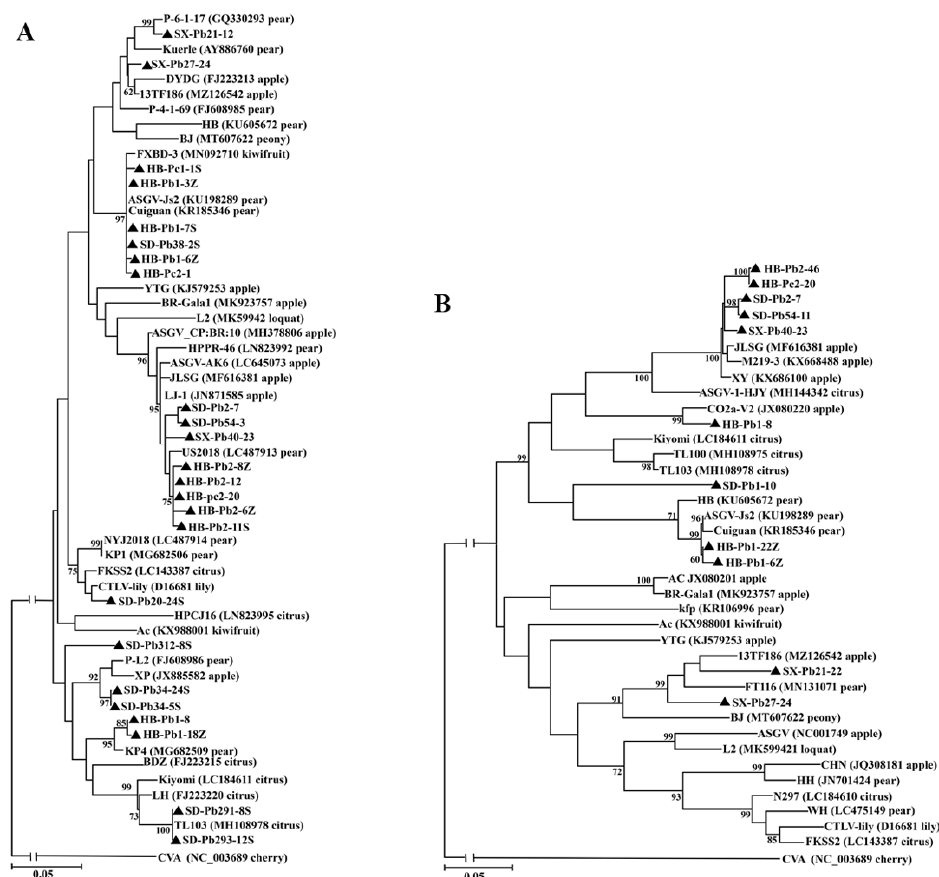
Figure 2. Unrooted maximum-likelihood (ML) phylogenetic trees generated from the nucleotide sequences of CP ( A ) and MP ( B ) genes of apple stem grooving virus (ASGV). The reported sequences in each tree were marked by its isolate name followed by a GenBank accession number and host name. The sequences determined in this study were highlighted by black triangles and marked by their geographic origins, hosts and clone IDs, and sequences from seedlings and seeds were identified with ‘S’ and ‘Z’. The corresponding RNA sequence of cherry virus A (CVA) was used as a outgroup in each phylogenetic